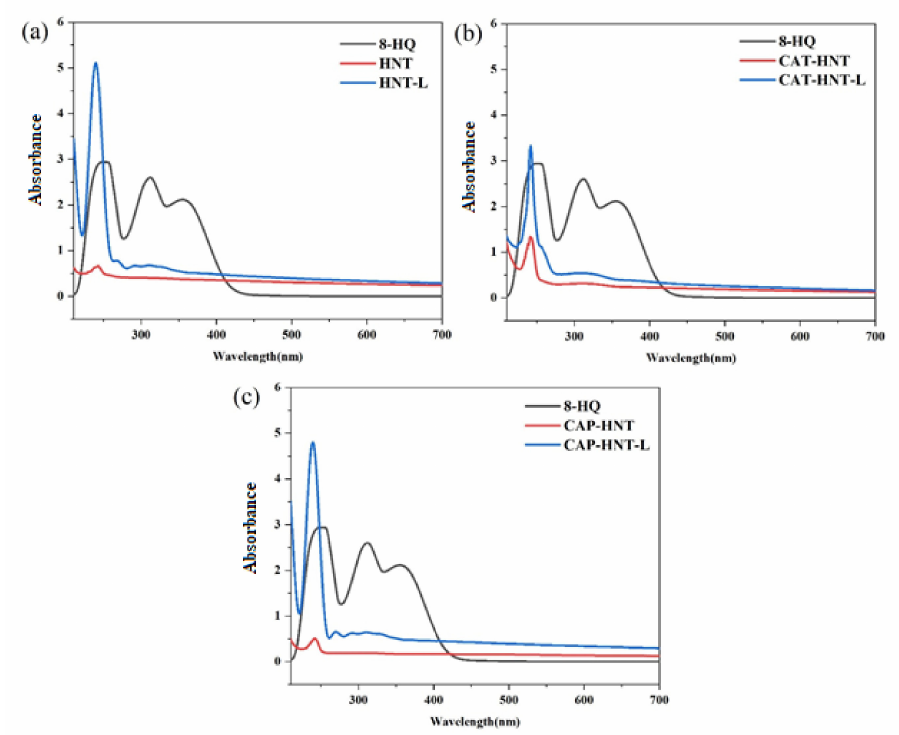
Figure 5. UV-visible spectra of 8-HQ, unloaded and loaded nanoparticles: ( a ) HNT, ( b ) CAT-HNT, ( c )